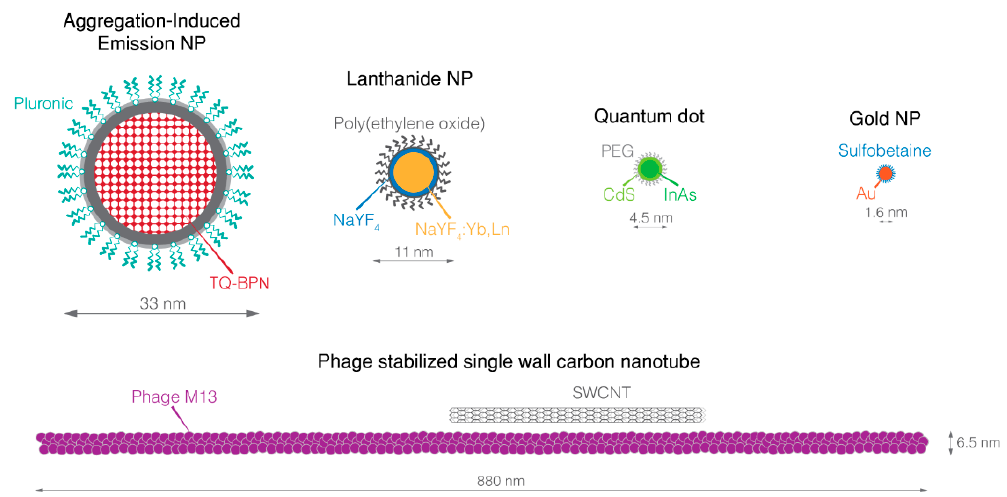
Figure 2. Overview of SWIR nanoparticles. NP, nanoparticle; PEG, poly(ethyleneglycol); SWCNT, Single-walled carbon nanotube; TQ-BNP, N , N ′ -((6,7-diphenyl-[1,2,5]thiadiazolo[3,4-g]quinoxaline-4,9-diyl)bis(4,1-phenylene))bis( N -phenylnaphthalen-1-amine).